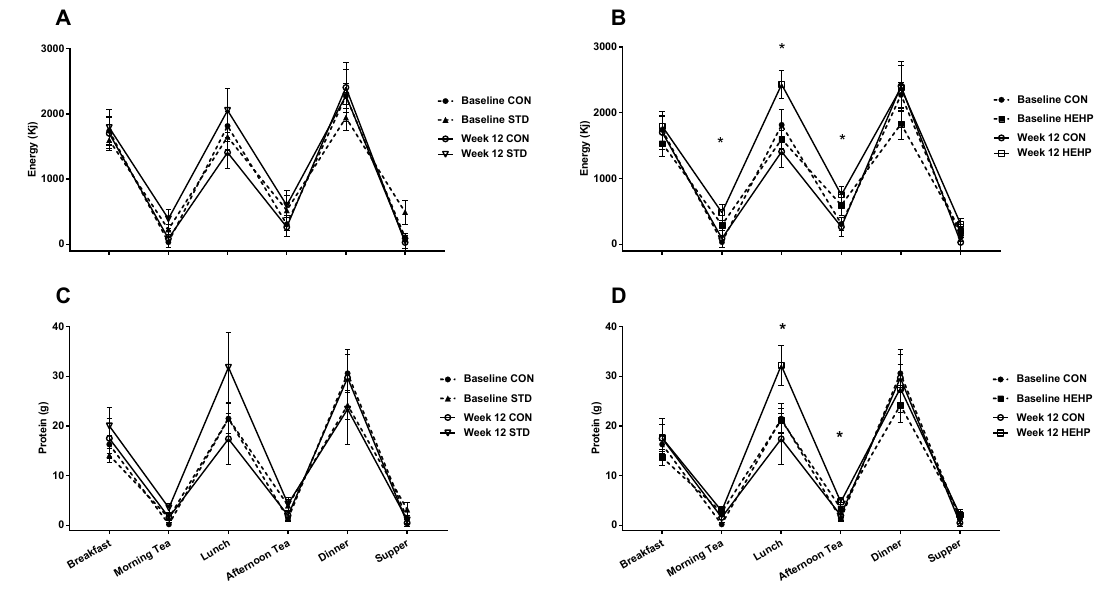
Figure 2. Patterns of energy and protein intake for ( A and C ) STD vs. CON and ( B and D ) HEHP vs. CON. Data presented as unadjusted mean energy and protein intakes at various eating occasions throughout the day at baseline and week 12. One-way ANOVA was used to compare differences in baseline parameters between the three groups and there were no significant differences between groups (all Ps > 0.05). ANCOVA of the week 12 data was performed using fixed effects for treatment group, age, gender, baseline energy, and the baseline value of the corresponding outcome; * Significant difference between HEHP and CON at week 12.